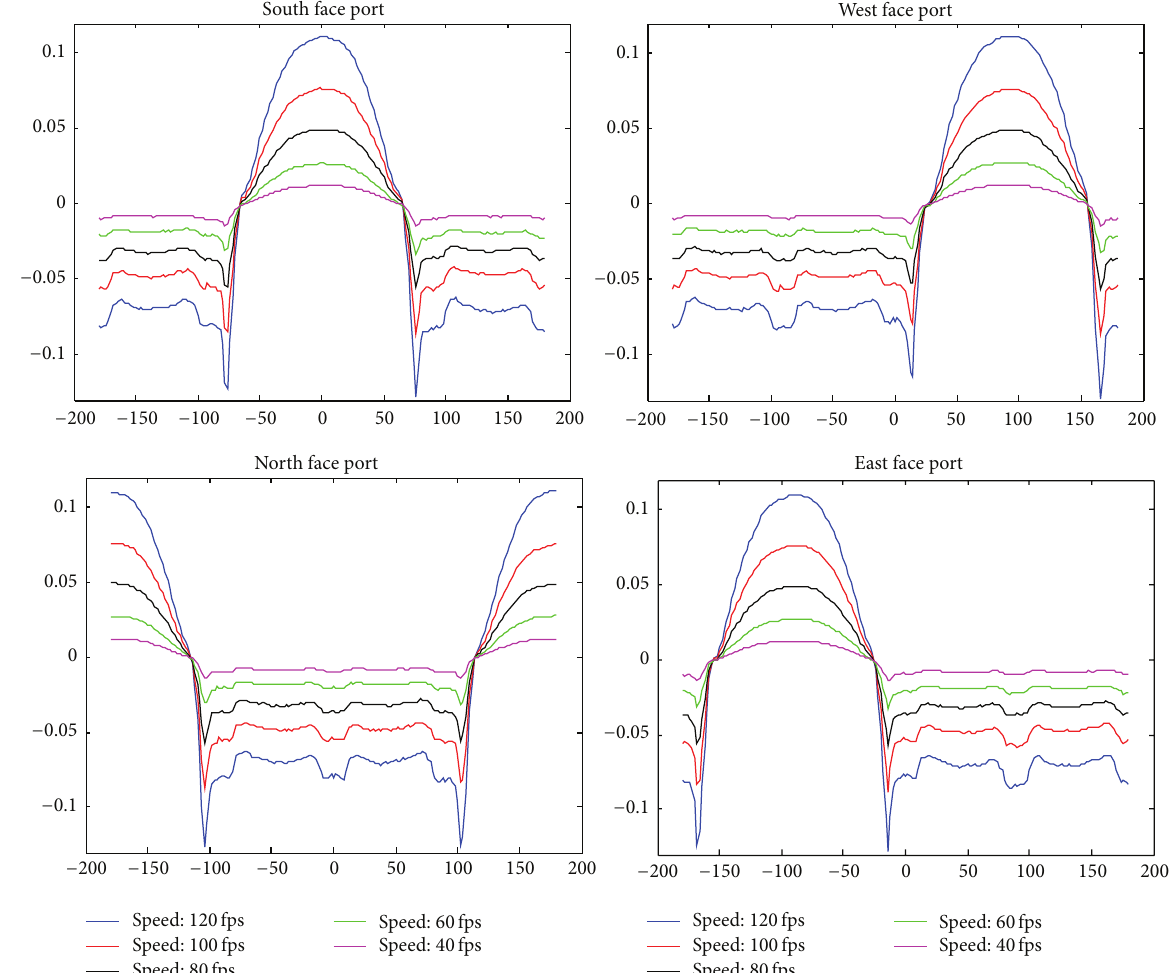
Figure 5: Surface pressure (psi) variation versus the yaw angle for different wind